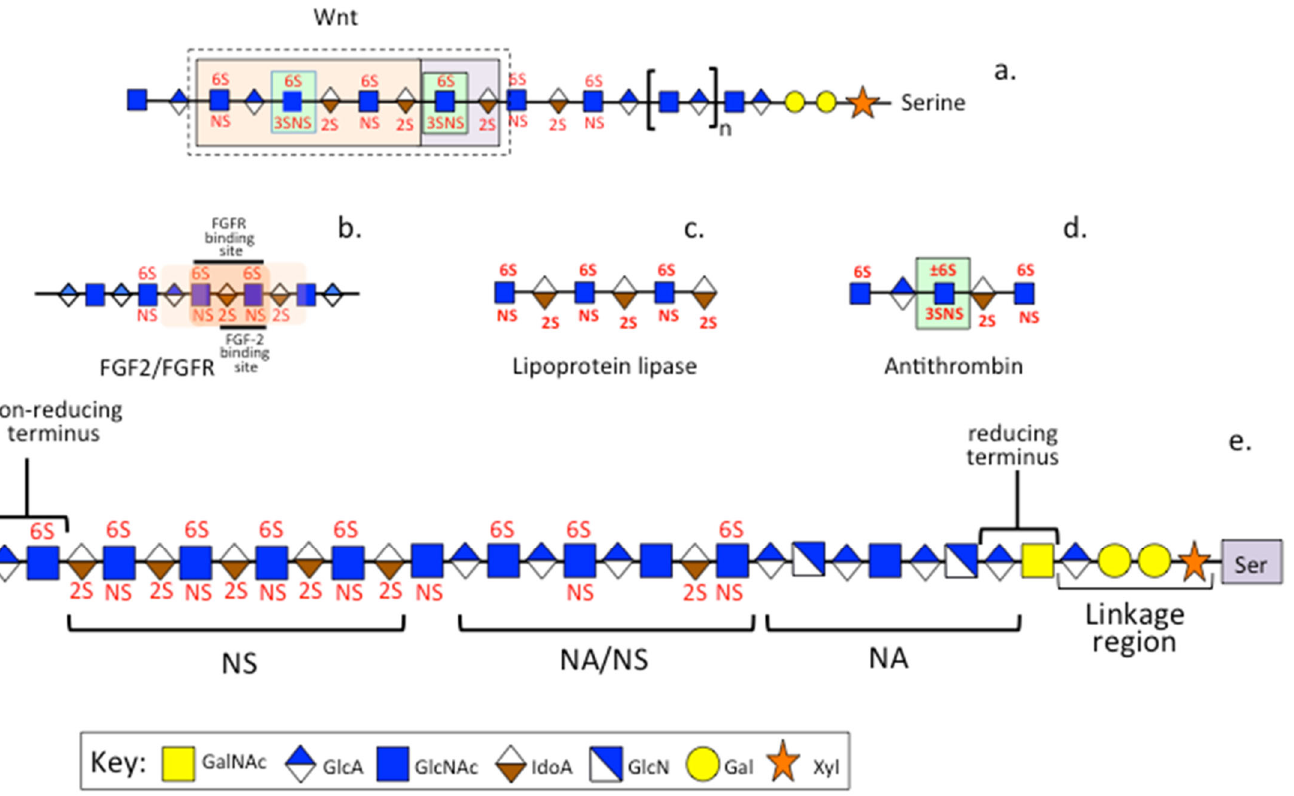
Figure 3. Binding sequences in HS determined for Wnt ( a ), lipoprotein lipase ( b ), antithrombin ( c ) and the FGF-2 and FGFR binding sites ( d ). Schematic depiction of the structural organization of a putative HS chain depicting its reducing and non-reducing termini, linkage region to a serine residue in a proteoglycan core protein. ( e ) Regions of high sulfation (NS domains), high acetylation (NA domains) and mixed regions (NA/NS domain) in a putative HS chain are also shown. Note: while heparin and HS have similar structures, heparin is fully modified and does not contain